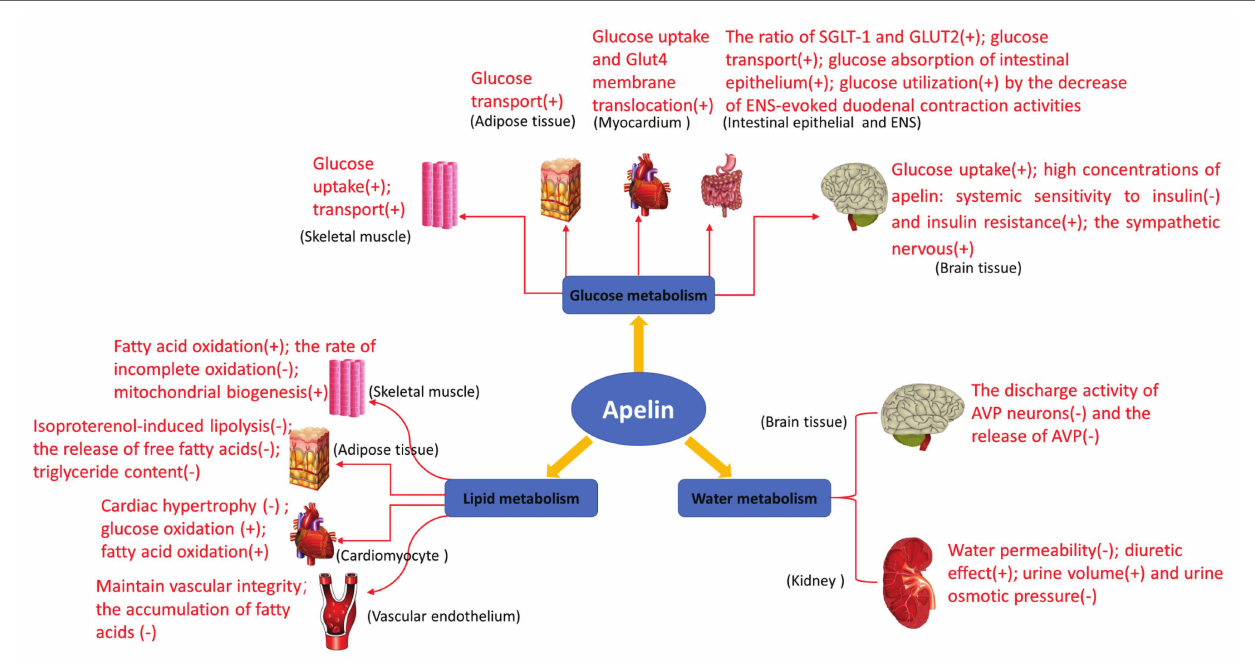
FIGURE 4 | Biological functions of apelin in glucose metabolism, lipid metabolism, and water metabolism. Glucose metabolism: apelin promotes glucose uptake in skeletal muscle cells and adipose tissues, and increases overall glucose utilization; it also increases glucose uptake and Glut4 membrane translocation in mouse myocardium in vivo ; it increases the net glucose flow of gastrointestinal mucosal barrier and enhances the glucose transport from intestinal lumen to blood in the intestinal epithelium; it improves glucose utilization by the decrease of enteric nervous system (ENS)-evoked duodenal contraction activities; and it regulates glucose homeostasis and promotes glucose uptake and utilization in the brain of the normally fed mice. High concentrations of apelin reduce systemic sensitivity to insulin and produce insulin resistance, activate the sympathetic nervous system through reactive oxygen species (ROS) signaling pathways, and promote hepatic glycogenolysis and gluconeogenesis in the brain of obese or diabetic mice. Lipid metabolism: apelin increases perilipin content around lipid vesicles and reduces free fatty acid (FFA) release from adipocytes by inhibiting lipolysis. Apelin also increases fatty acid oxidation in skeletal muscle and myocardium, reducing the rate of incomplete oxidation of long-chain acylcarnitines associated with insulin. In addition, apelin may prevent the development of obesity and atherosclerosis by reducing the release of free fatty acids and increasing perilipin content around lipid vesicles, and prevents fatty deposits in the blood vessels and plaque formation. Water metabolism: the expression of apelin/APJ in magnocellular neurons of the hypothalamus and periventricular organelles suggests that it may be involved in the regulation of body fluid balance. Apelin and its receptor APJ are expressed in all regions of human and rat kidneys, regulating body fluid homeostasis at the kidney